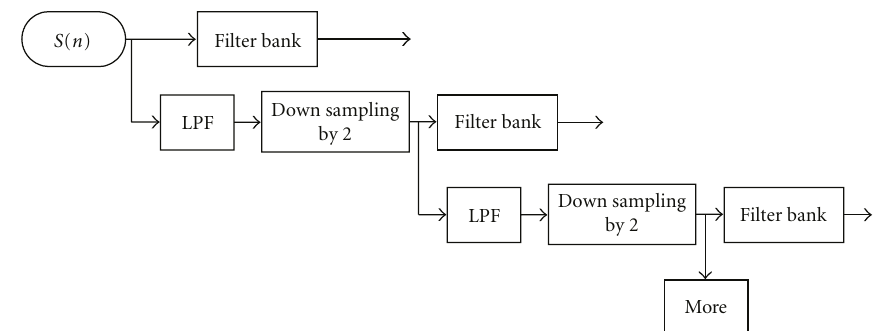
Figure 1: Block diagram of the multiresolution